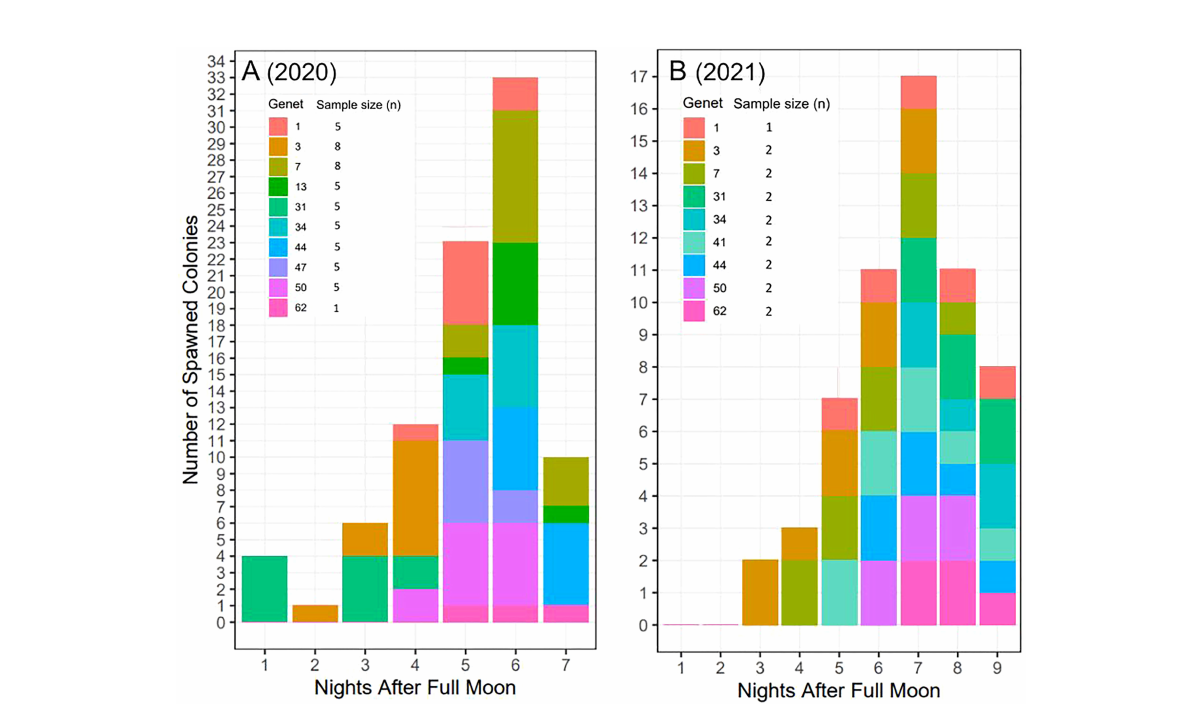
FIGURE 7 Ex-situ broadcast spawning timing data for A. cervicornis genets used for managed breeding and active restoration. Timing is relative to the (A) August 3, 2020 full moon (52 colonies; 10 genets) and (B) July 23, 2021 full moon (17 colonies; 9 genets). In both years, every colony and genet spawned, with nearly all colonies spawning across multiple nights, often consecutively. Across both years, corals spawned during the predicted window for this species and region (i.e., 1-15 NAFM), with peak spawning activity observed on night 6 in 2020 and on night 7 in